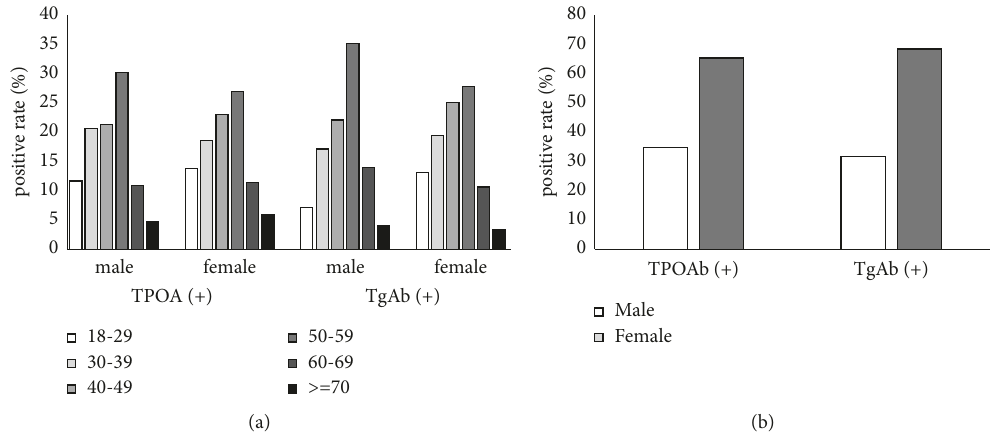
Figure 2: (a) Positive rates of autoantibodies in different age groups. (b) Positive rates of autoantibodies in different gender